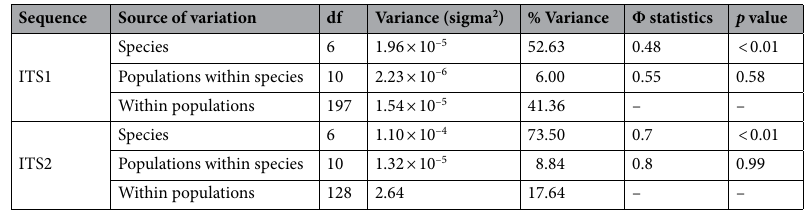
Table 3. Hierarchical AMOVA results for ITS1 and ITS2 regions.